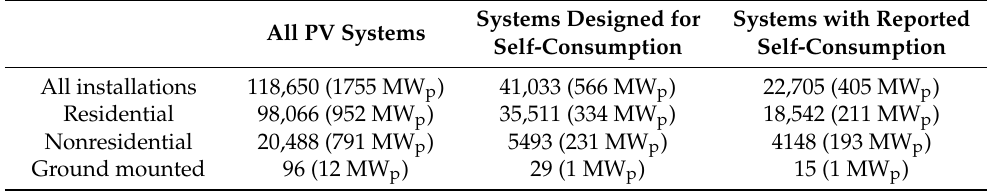
Table 2. Composition of the full model portfolio with the number of PV systems (total nominal power in parentheses) by type of installation and information on self-consumption